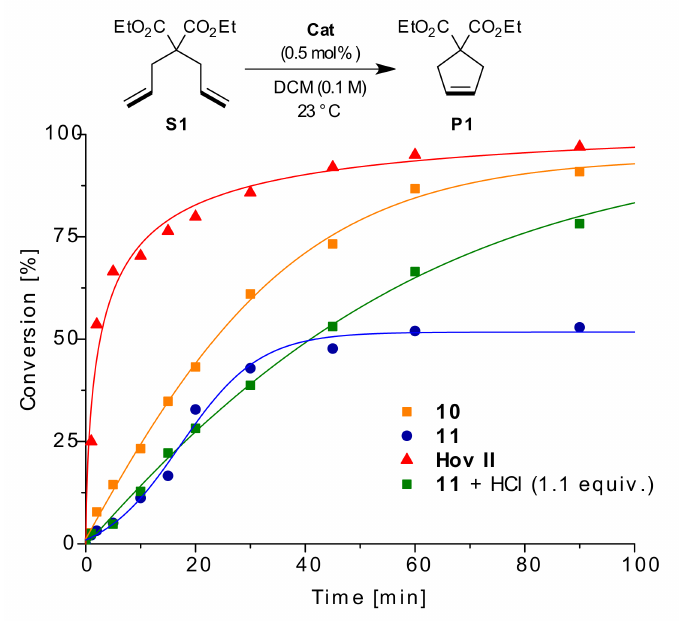
Figure 3. Conversion to product P1 using catalysts 10 , 11 , and Hov II . Conversions according to 1 H-NMR, curves are visual aid